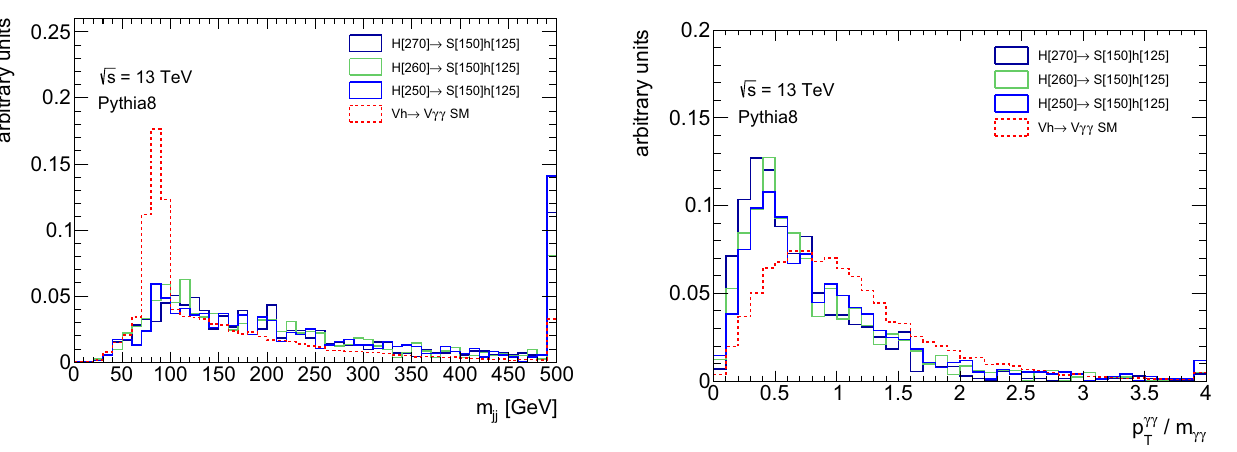
Fig. 6 Ratio between the transverse momentum and the invariant mass of the diphoton system in events with at least two jets for several H → Sh samples (solid lines) compared with the SM Vh process with h → γγ (dashed line) generated with PYTHIA8 . The last bin contains overflow